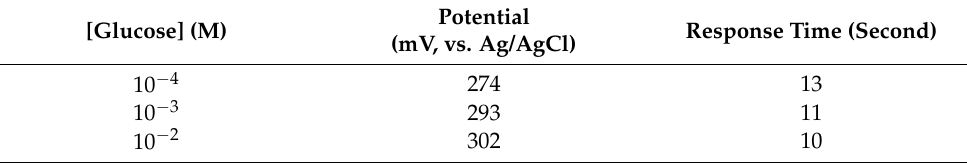
Table 6. Data of E2 electrode response time in glucose solution